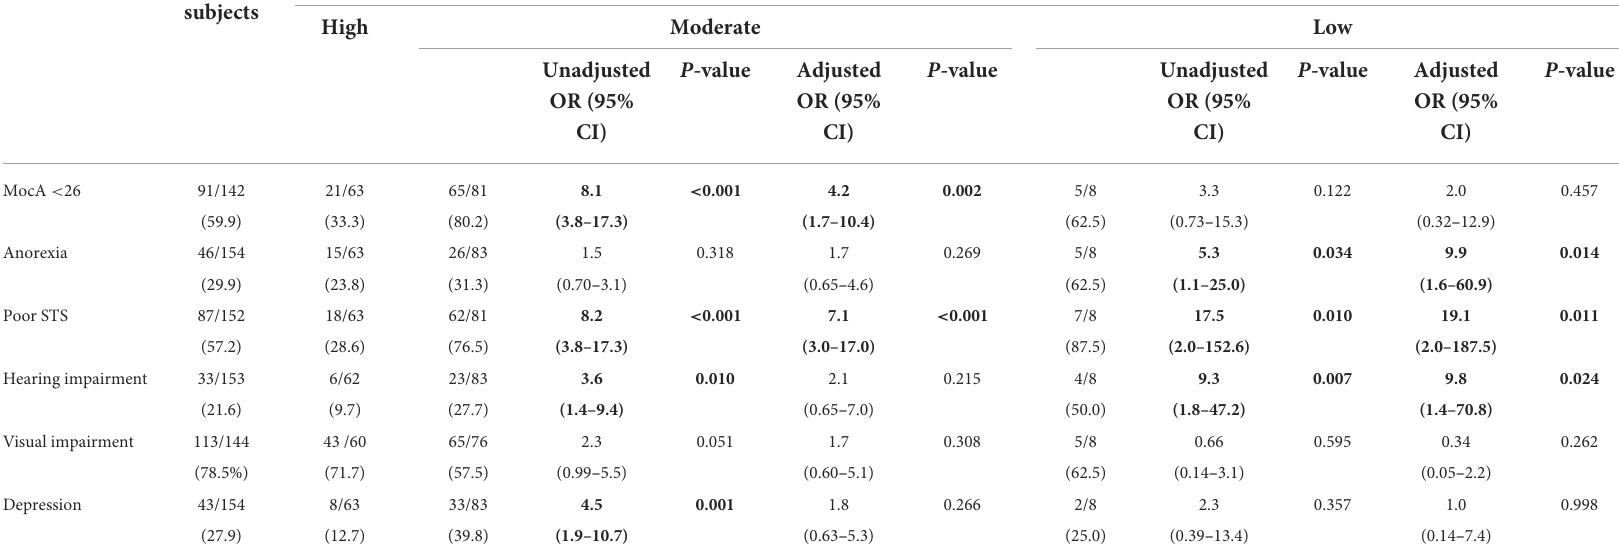
TABLE 4 Intrinsic capacity and association with participation